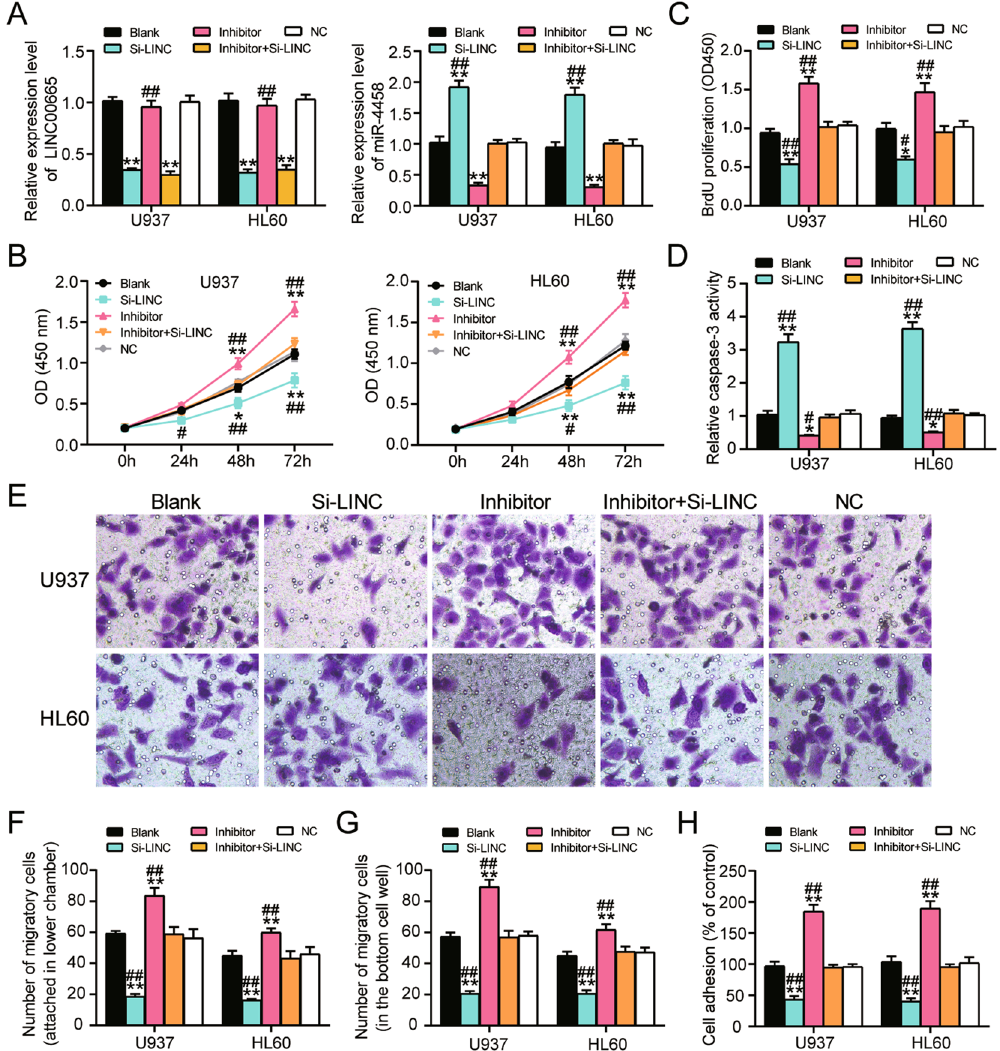
Figure 3. MiR-4458 promotes AML cells proliferation and adhesion and inhibit AML cells apoptosis. ( A ) qRT- PCR analysis of LINC00665 expression in U937 and HL60 cells transfected with LINC00665 siRNA (si-LINC), miR-4458 inhibitor (inhibitor), LINC00665 siRNA and miR-4458 inhibitor (inhibitor + si-LINC), negative control (NC) or cells with no treatment (Blank). ( B ) CCK-8 assay was conducted to evaluate the cell viability of U937 and HL60 cells in blank group, si-LINC group, inhibitor group, inhibitor + si-LINC group and NC group after culture for 0 h, 24 h, 48 h, 72 h. ( C ) BrdU assay was performed to determine the proliferative capacity of U937 and HL60 cells in the above groups. ( D ) Caspase-3 activity was evaluated to reflect the apoptosis of U937 and HL60 cells in the above groups. ( E – G ) The migration ability of U937 and HL60 cells in the above groups was evaluated by transwell assay. ( E ) Representative picture and ( F ) Statistical analysis of migratory cells attached in the bottom chamber. ( G ) Statistical analysis of migratory cells migrated into the culture medium of lower cell well. ( H ) The cell adhesion capacity of U937 and HL60 cells in the above groups was analyzed by cell adhesion assay. Three biological repeats were performed for each experiment, and the data were shown as mean ± SD. Statistics analysis was carried out with Student’s t -test or one-way ANOVA. * P < 0.05; ** P < 0.001 versus Blank group; # P < 0.05; ## P < 0.001 versus inhibitor + si-LINC